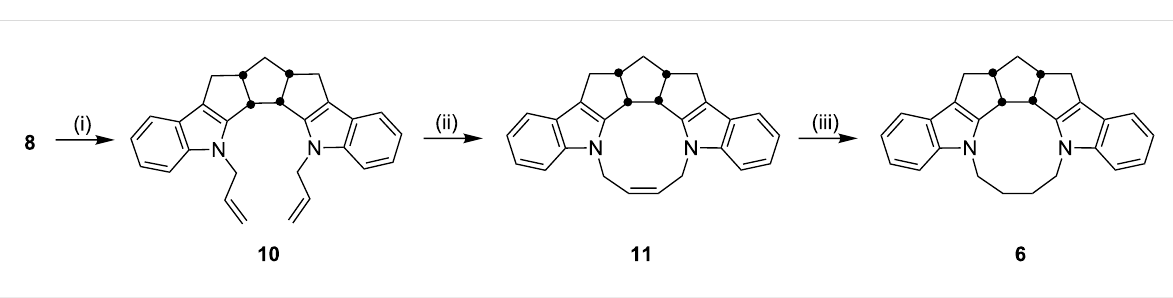
Scheme 3: Synthesis of the macrocyclic aza-polyquinane derivative 6 . Reagents and conditions: (i) NaH, allyl bromide, DMF, rt, 24 h, 65%; (ii) G-II,